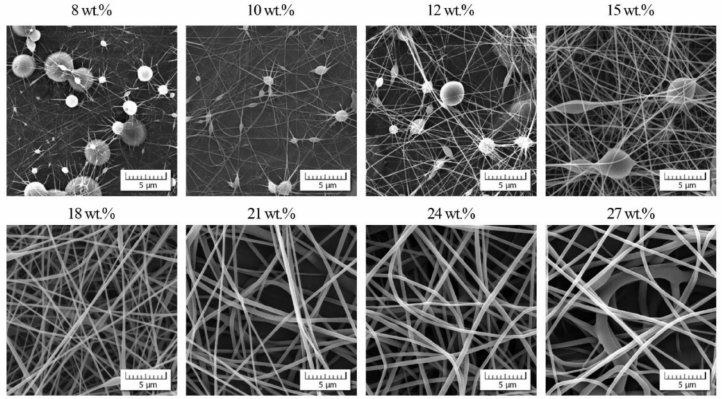
Figure 6. Scanning electron micrographs (SEM) showing the morphology of individual nanofibers for various copolymer concentrations and DMF/acetone ratio